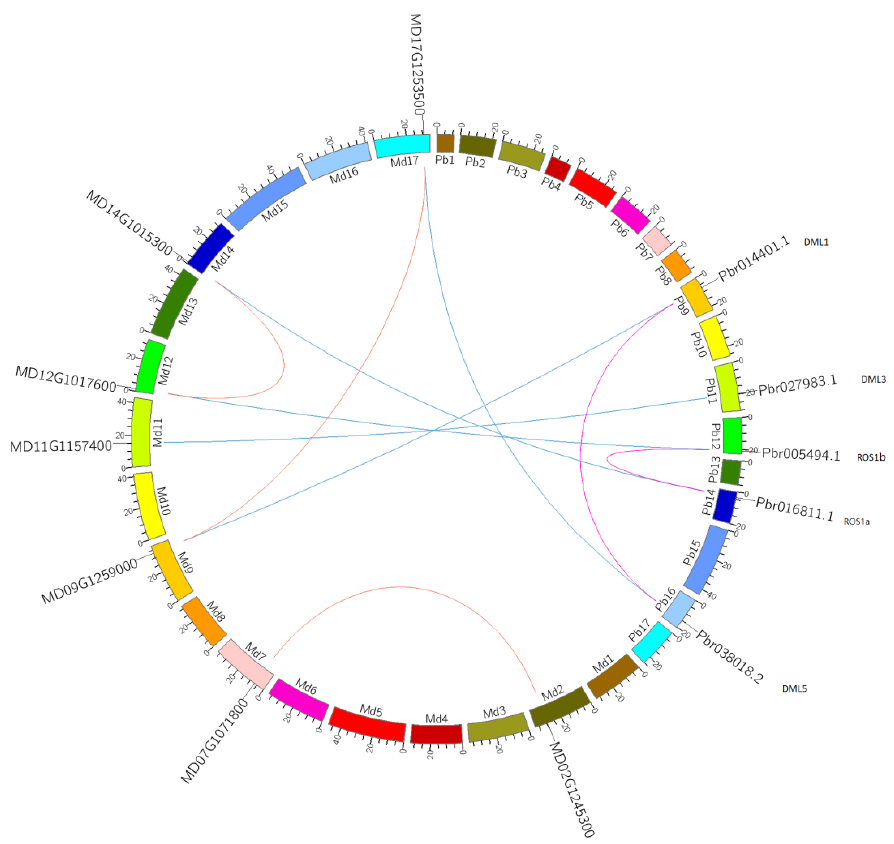
Figure 4. Intra- and interspecific K s comparisons of DME genes in the pear and apple genome. The pink and orange lines indicate intraspecific synteny of DME genes in pear and apple, the blue lines indicated interspecific synteny between pear and apple.